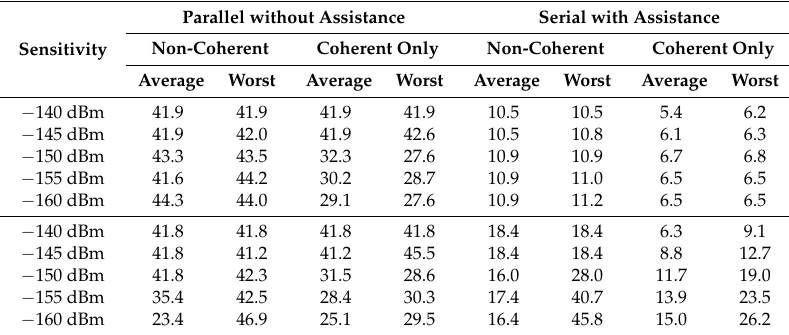
Table 20. Ratio of complexity (product of processing time ratio and memory ratio) between the E5 signal and the E1 signal with a sampling frequency of 4.096 MHz. Top rows do not consider the input memory, while bottom rows consider the input memory.